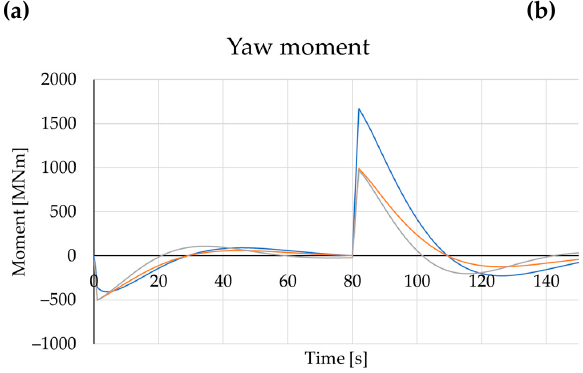
Figure 6. Comparison between three different hydrodynamic forces: ( a ) Surge force, ( b ) Sway force, ( c ) Yaw moment. ( c ) Yaw